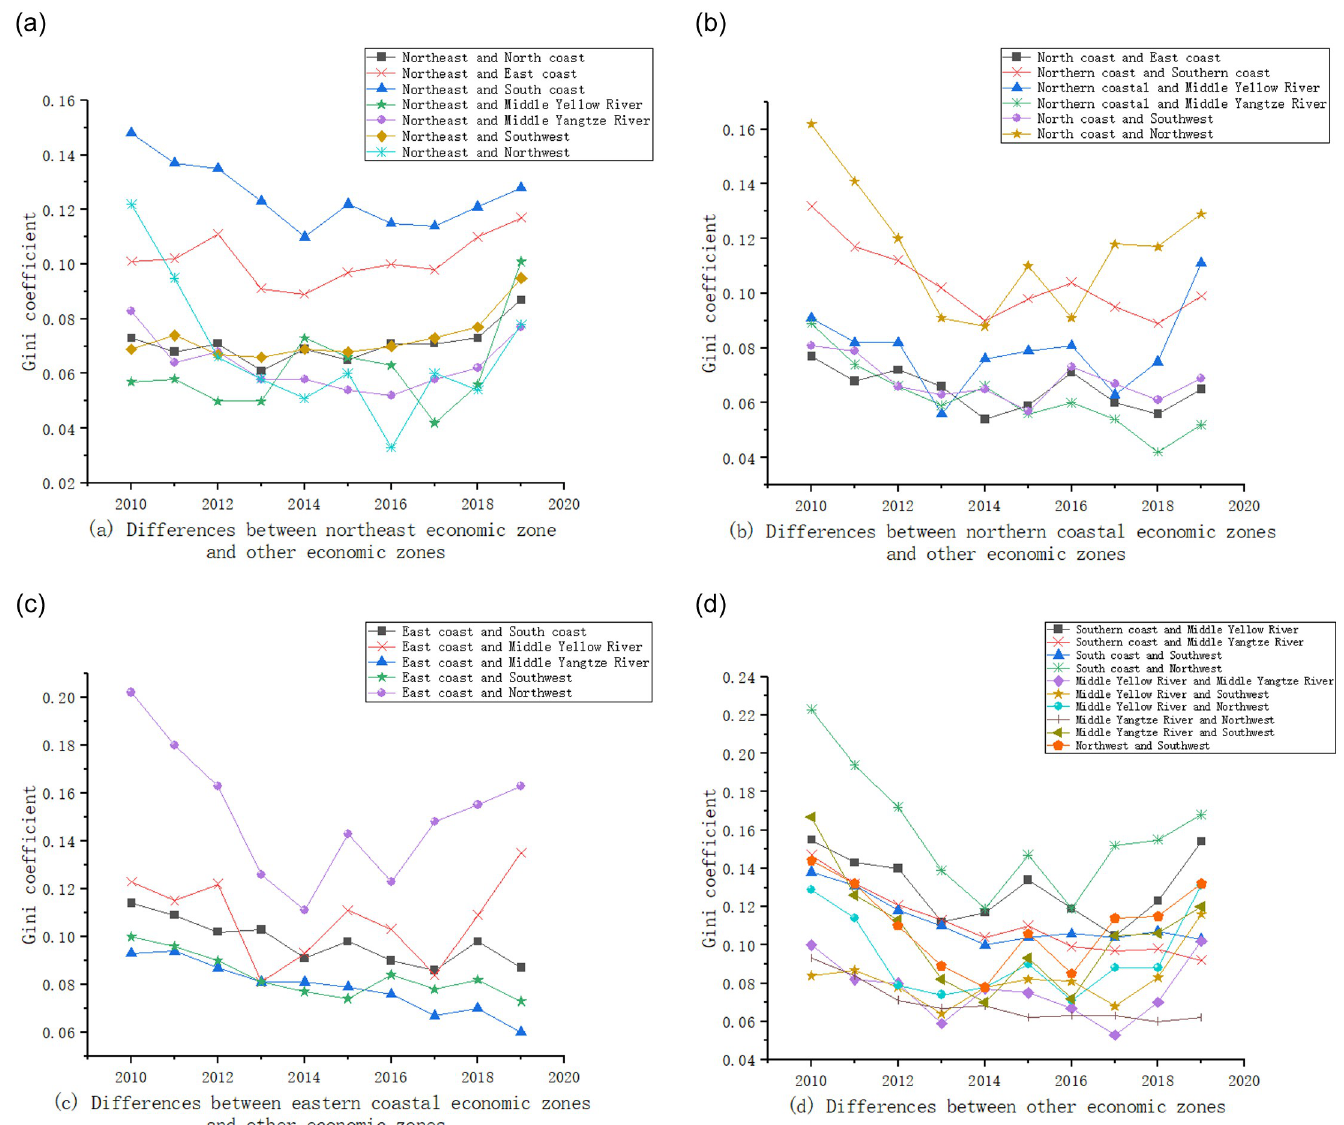
Fig 6. Inter-regional difference in the coupling coordination degree of the energy-economy-carbon emission